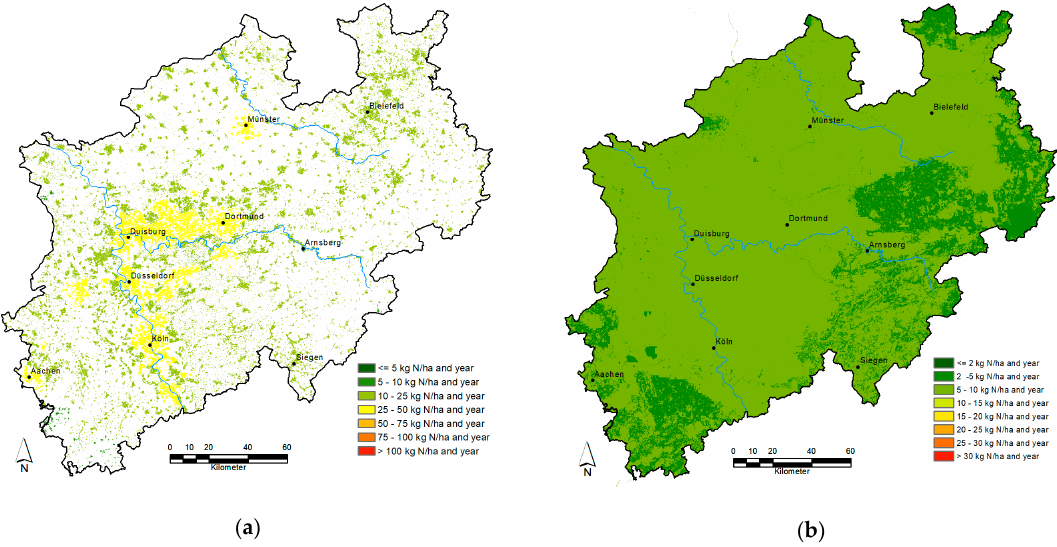
Figure 6. ( a ) Nitrogen output from urban systems and small sewage treatment plants, and ( b ) atmospheric NOx deposition (2013–2015).